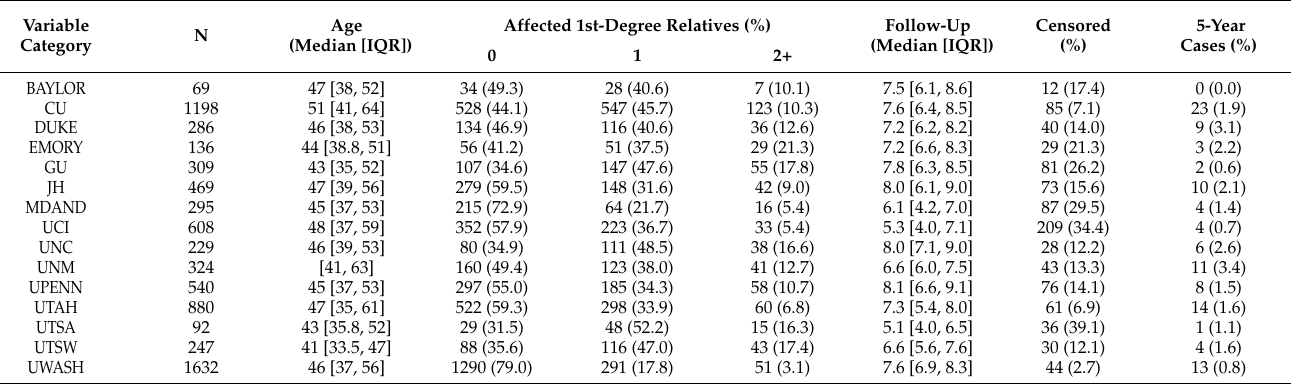
Table A4. CGN cohort characteristics by